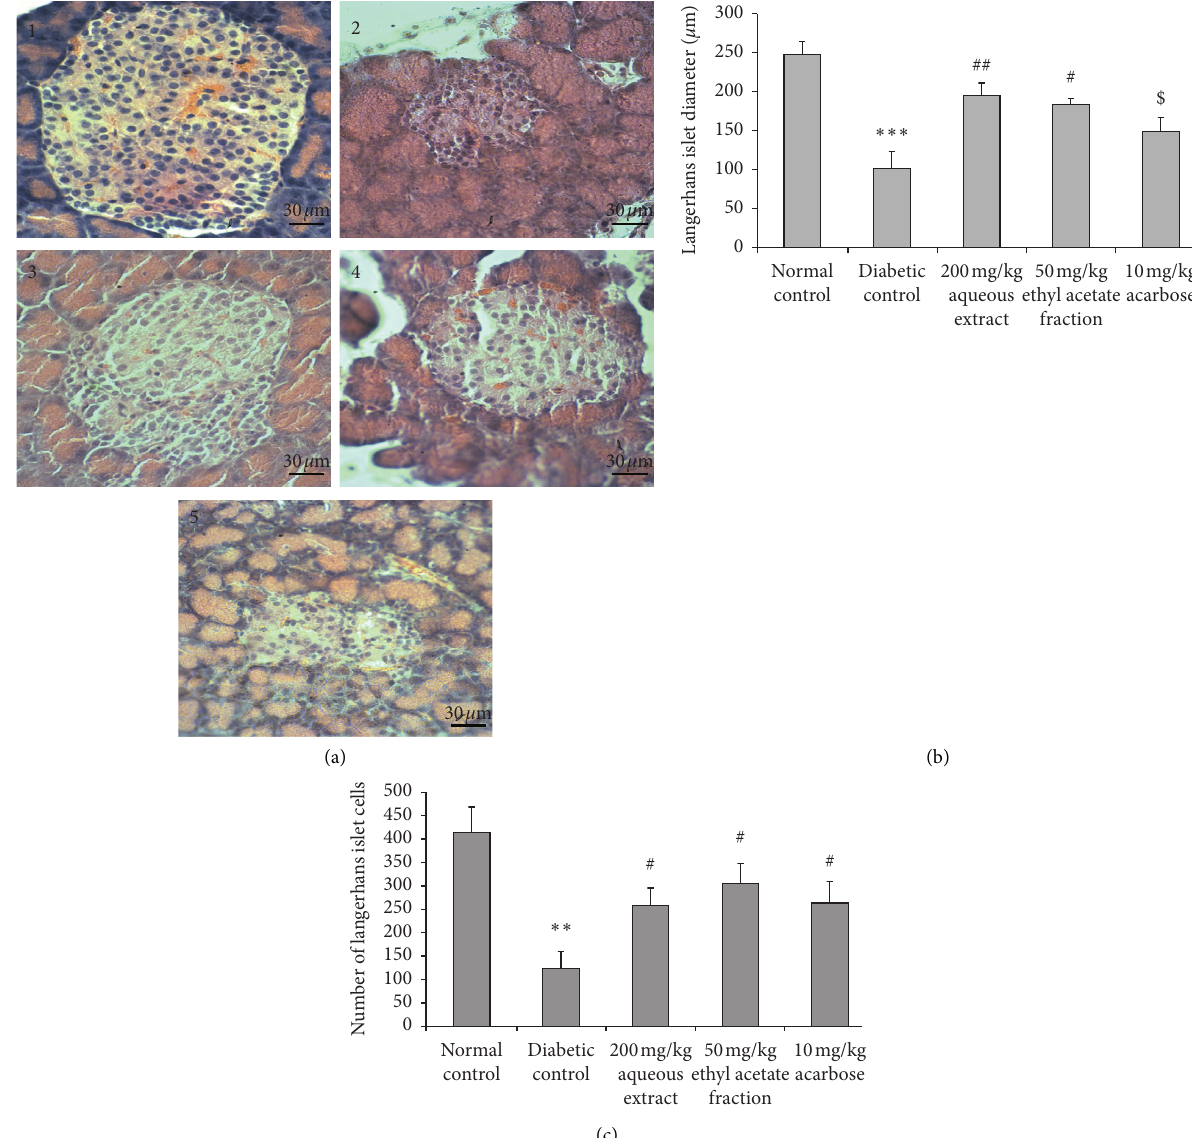
Figure 3: Effect of 200mg/kg aqueous extract (AqTh), 50mg/kg ethyl acetate (EaTh), and 10mg/kg acarbose treatment on diameter and number of pancreatic Langerhans islet cells in STZ-induced diabetic rats after 4-week treatment. (a) Histological appearance of Langerhans islets in normal (1), diabetic (2), AqTh-treated (3), EaTh-treated (4), and acarbose-treated rats (5). (b) Diameter of Langerhans islets for all groups. (c) Number of Langerhans islet cells for all groups. Sections were stained in hematoxylin and eosin and observed in light microscope (original magnification × 400). ∗∗ p < 0 . 01 and ∗∗∗ p < 0 . 001 compared to normal rats; $ p > 0 . 05, # p < 0 . 05, and ## p < 0 . 01 compared to diabetic rats. Each value represents the means ± SEM. n � 5-6.